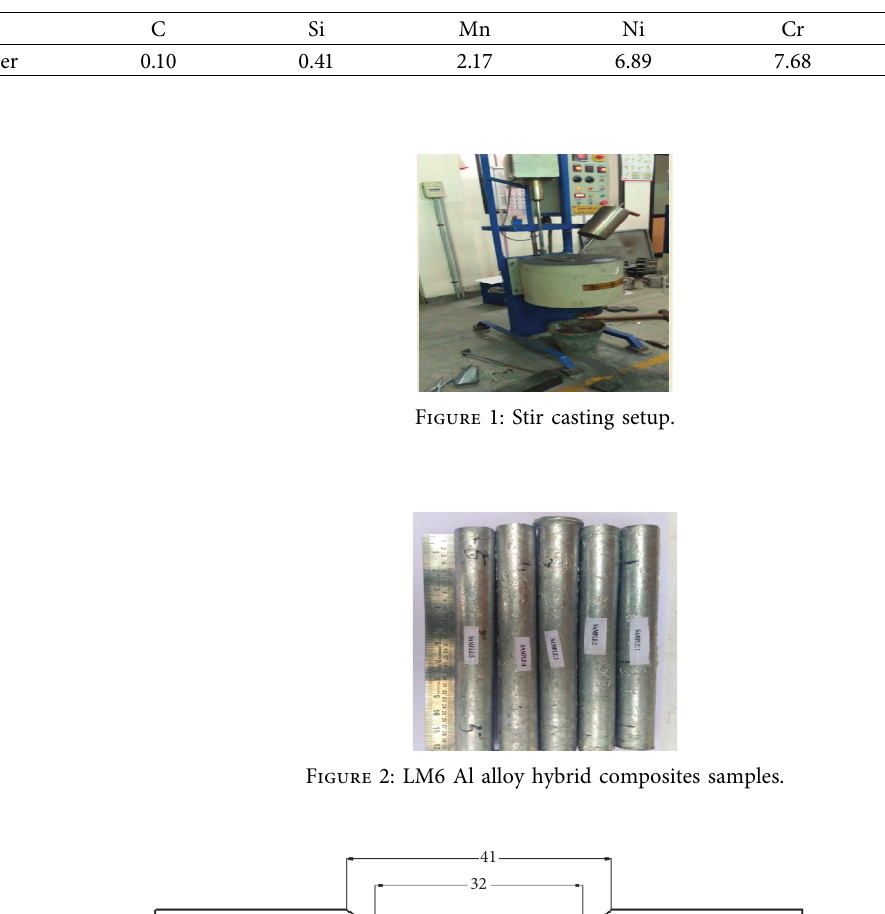
Table 2: Chemical composition of steel fiber (wt. %).